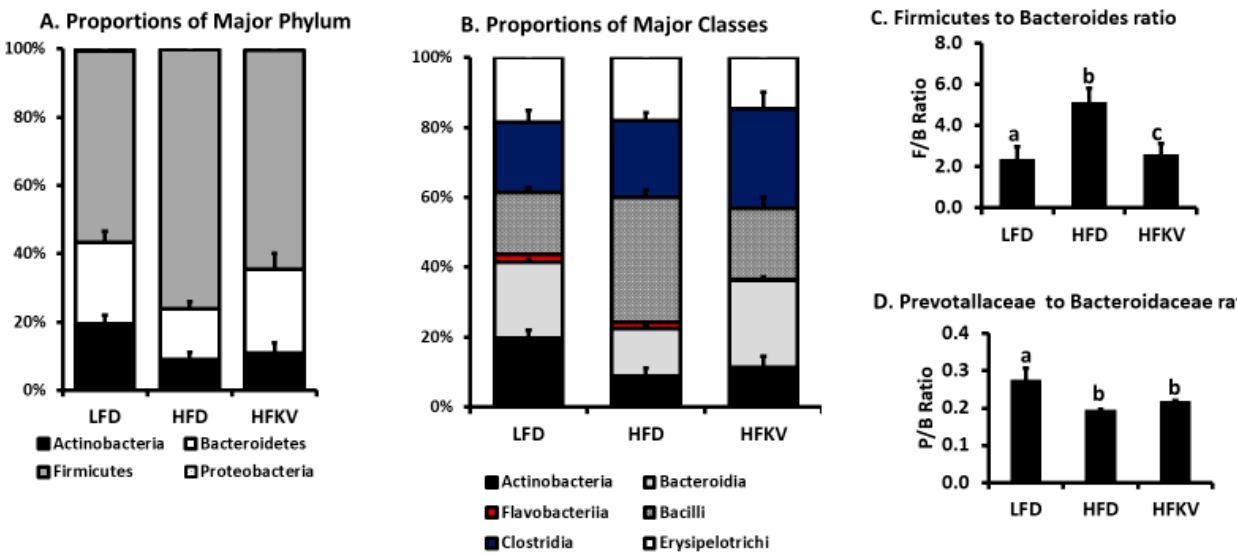
Figure 2. Histograms of relative abundance. ( A ) Relative abundance of the top 4 phyla. The Y -axis represents relative abundance presented as a percentage; ( B ) Relative abundance of the top 6 classes; ( C ) Ratio of Firmicutes to Bacteroides was significantly higher in HFD compared to LFD ( p < 0.05) and HFKV lowered the ratio to levels of the LFD ( p < 0.05); ( D ) Ratio of Prevotallaceae to Bacteroidaceae was lower in the HFD compared to LFD ( p < 0.05) and HFKV had no significant effect ( p = ns). The letters ‘a’ ‘b’ ‘c’ denote statistically significant values at p < 0.05.